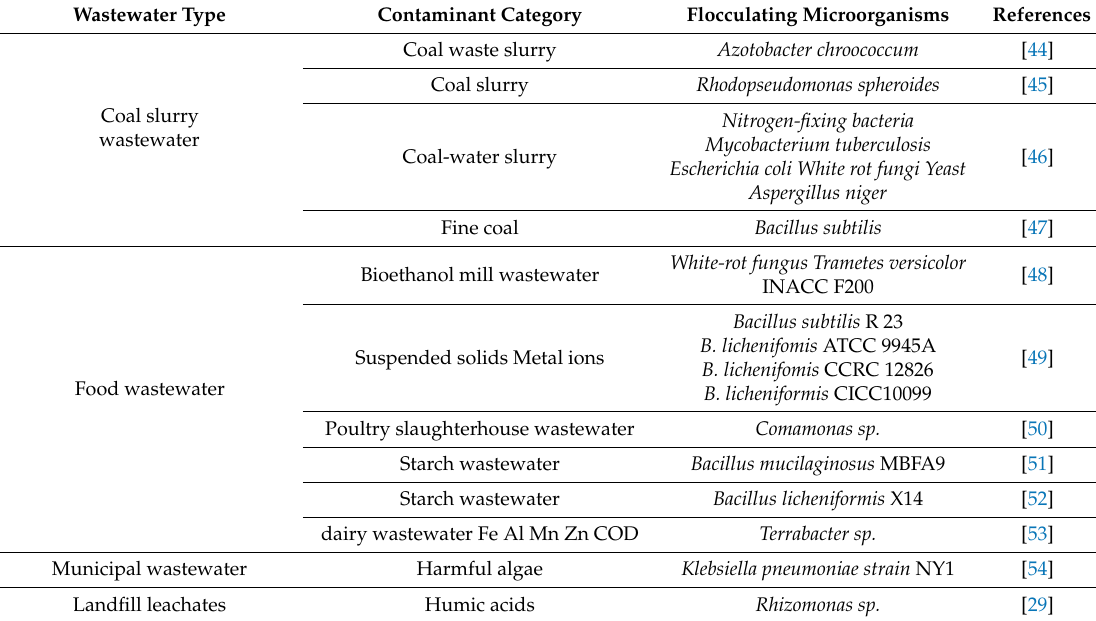
Table 2. Microbial flocculants used in several common